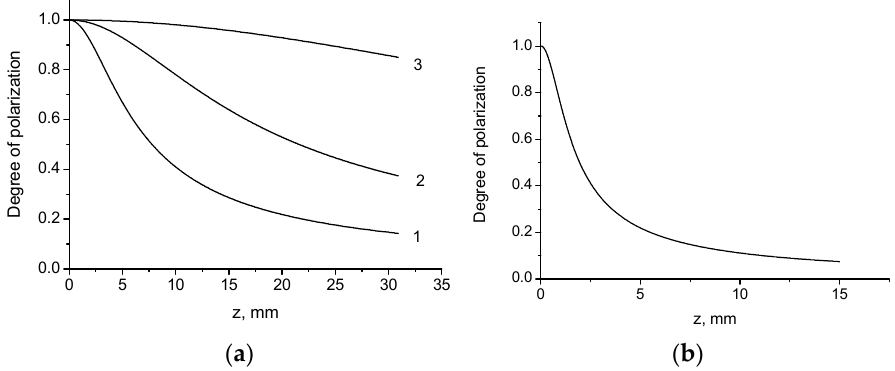
Figure 3. ( a ) Degree of polarization as function of distance. 1 − a 0 = 30 µ m; 2 − a 0 = 50 µ m; 3 − a 0 = 100 µ m. ( b ) Degree of polarization as function of distance. a 0 = 15 µ m.